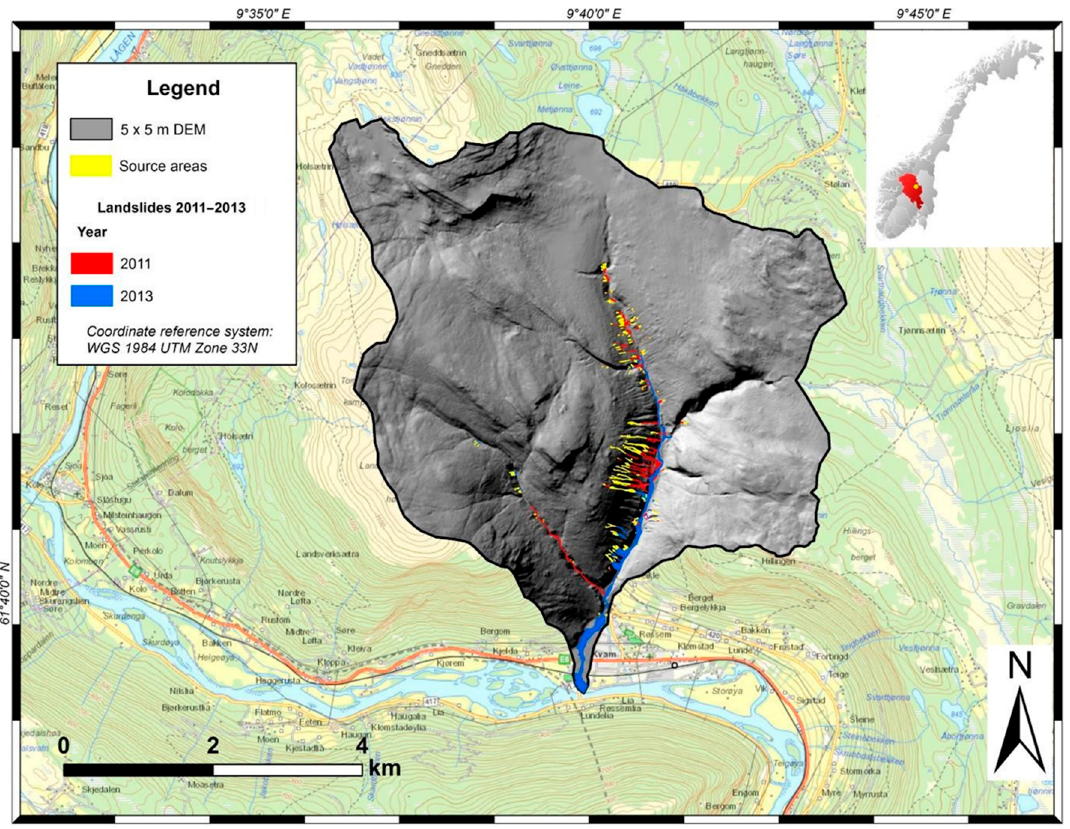
Figure 1. The 2011 and 2013 landslide inventory for the study area, whose location is shown in the sketch on the upper right (the yellow point represents the study area, the red area indicates the limits of former Oppland County).